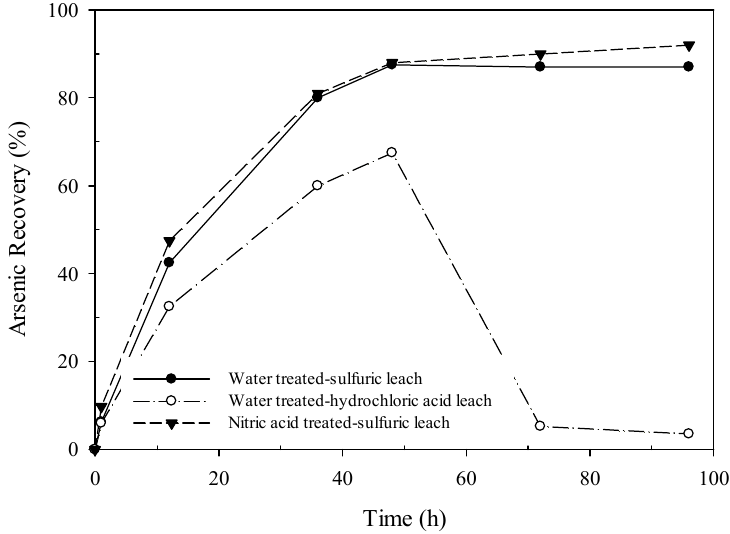
ff ect of acid type and catalyst pretreatment on arsenic Figure 9. Effect of acid type and catalyst pretreatment on arsenic recovery. Figure 9. E